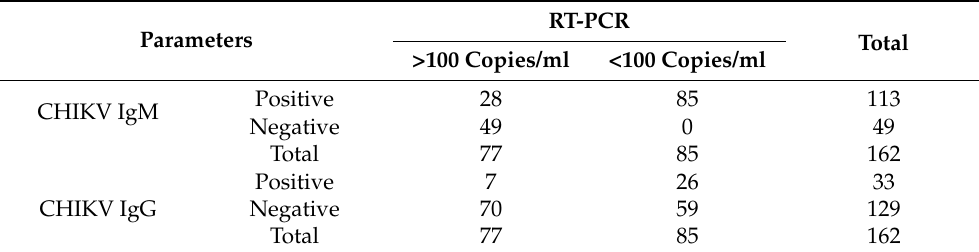
Figure 1. Results of the CHIKV lateral flow immunoassay and RT-PCR confirmation in patients ( n = 162). Percentage of positive RT-PCR, CHIKV specific IgM, and IgG tests per day of illness onset.